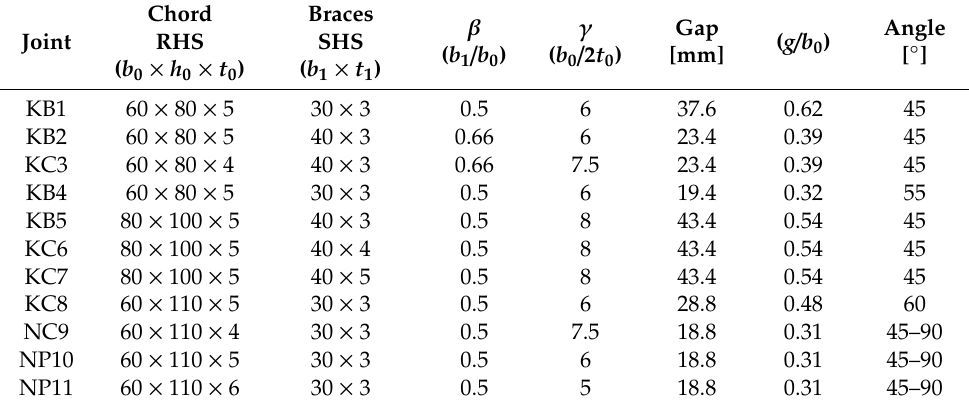
Table 3. Joint dimensions in the extended model.